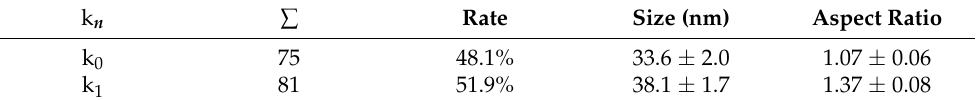
Table 1. Clustering summary for UCNP shape and size analysis. k n is the cluster number, ∑ and rate are the number and the fraction of particles for each cluster. Size and aspect ratio represents the mean size (diameter) and the mean aspect ratio of the particles for each cluster.